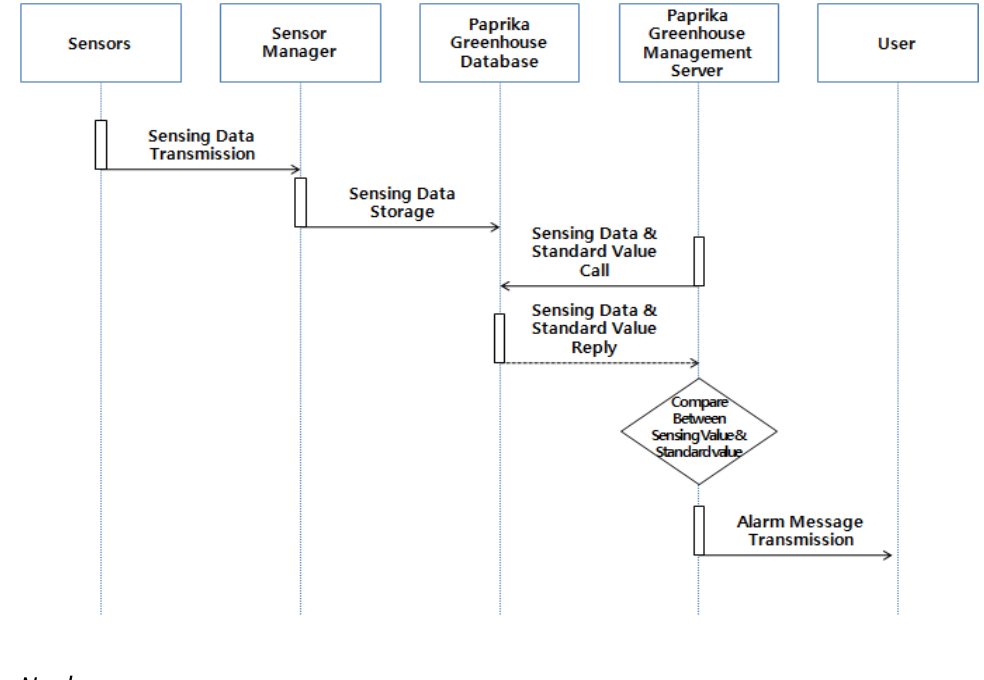
Figure 6. Operation process of the Paprika Greenhouse Status Alarm Services